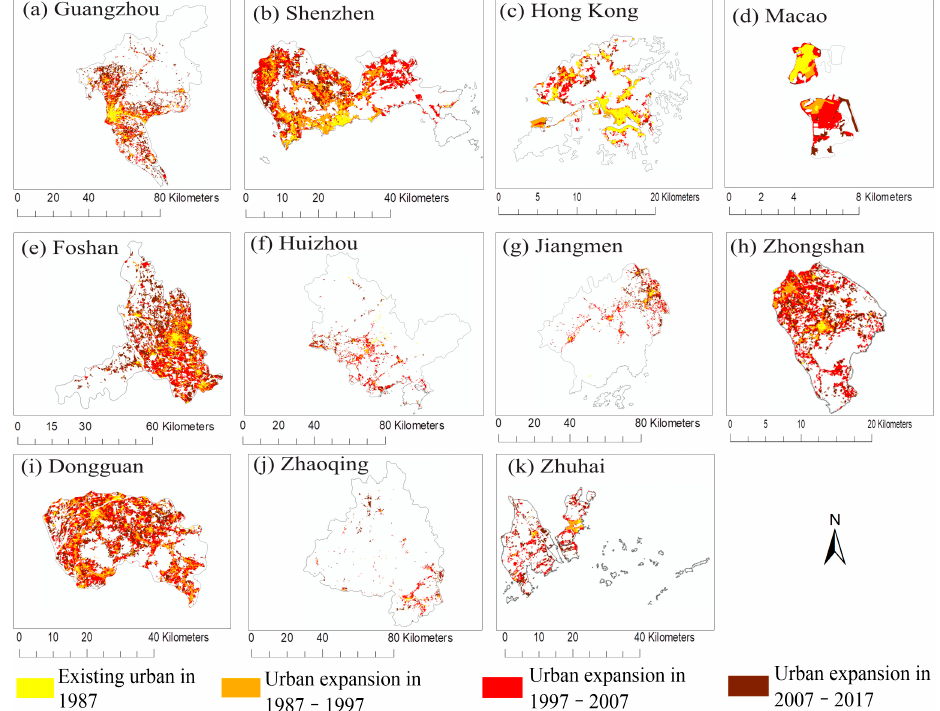
Figure 4. The spatial distribution of urban expansion in 11 cities in the GBA for three neighboring periods between 1987 and 2017.